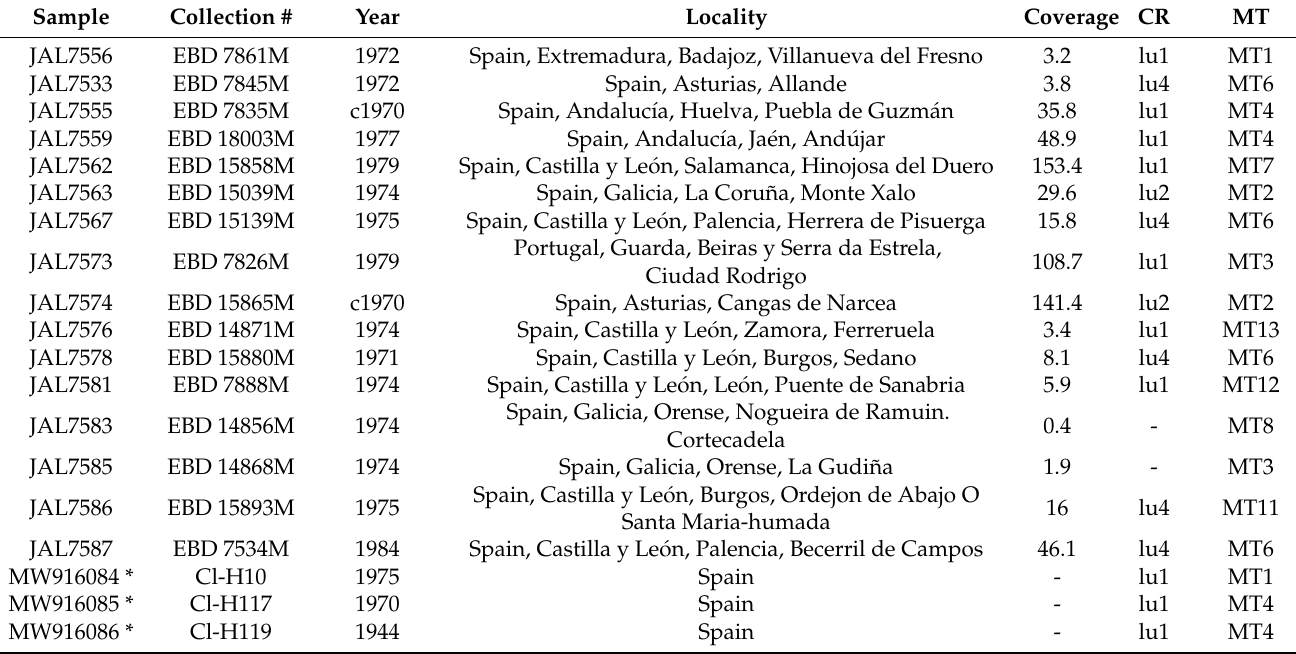
Table 1. Distribution of wolf haplotypes from historical Iberian wolves. Sample is lab ID; Collection # is scientific collection Catalog Number; Year; Locality; Coverage, calculated as total mapped sequence length divided by reference mitogenome size (16,727 bp); CR is haplotype for the 5 (cid:48) end of the control region and MT for the complete mitogenome except control region.